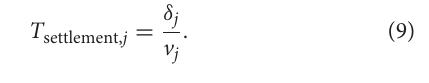
velocities ( Table 1 ) of POM compartments j = 1, 2, 3,